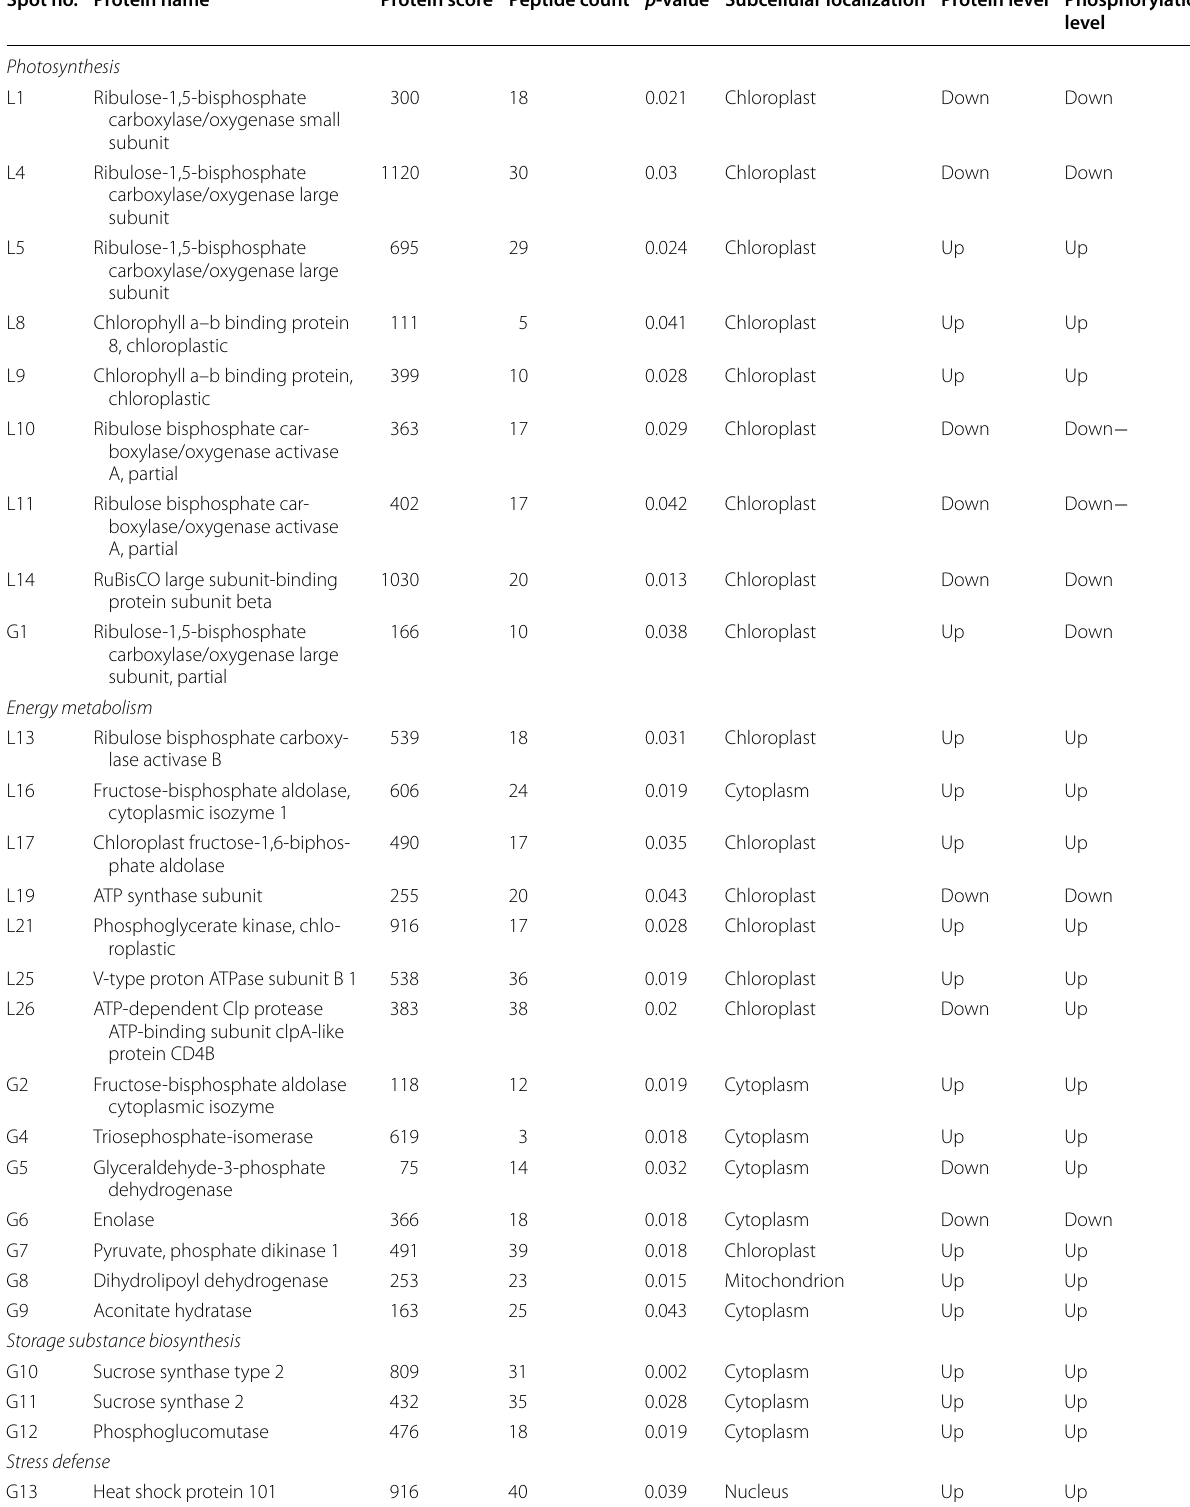
Table 1 Representative phosphorylated proteins identified by MALDI-TOF/TOF-MS and Pro-Q staining Spot no. Protein